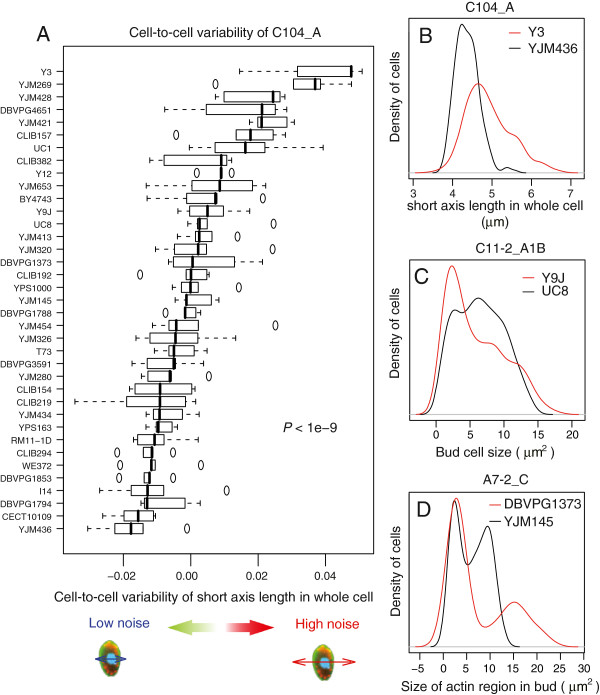
Wild strains display different levels of noise in single-cell traits. A) The ‘Noise’ level of trait C104_A (short axis length of whole cell at G1) corresponds to the residuals of the lowess regression shown in Figure 5D. The boxplot represents these noise values in every strains, the p-value indicates significance of a strain effect as determined by Kruskal-Wallis test. B) Distributions of single-cell values of C104_A in strains displaying low (black, YJM436) and high (red, Y3) noise for this trait. C) Distributions of single-cell values of C11-2_A1B (bud size at S/G2) in strains displaying low (black, UC8) and high (red, Y9J) noise for this trait. D) Distributions of single-cell values of A7-2_C (size of actin region in bud at M) in strains displaying low (black, YJM145) and high (red, DBVPG1373) noise for this trait.